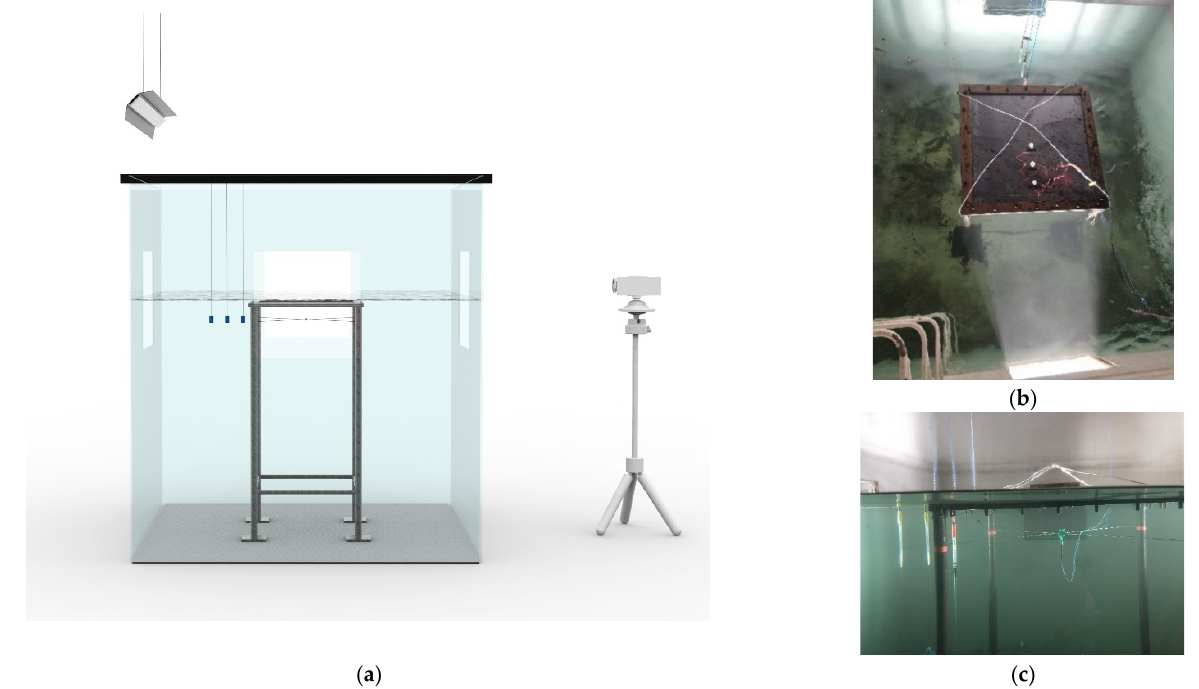
Figure 2. Overview of underwater explosion tests. ( a ) 3D view of water tank, specimen, and instruments. ( b ) Top view of specimen. ( c ) Front view of specimen.